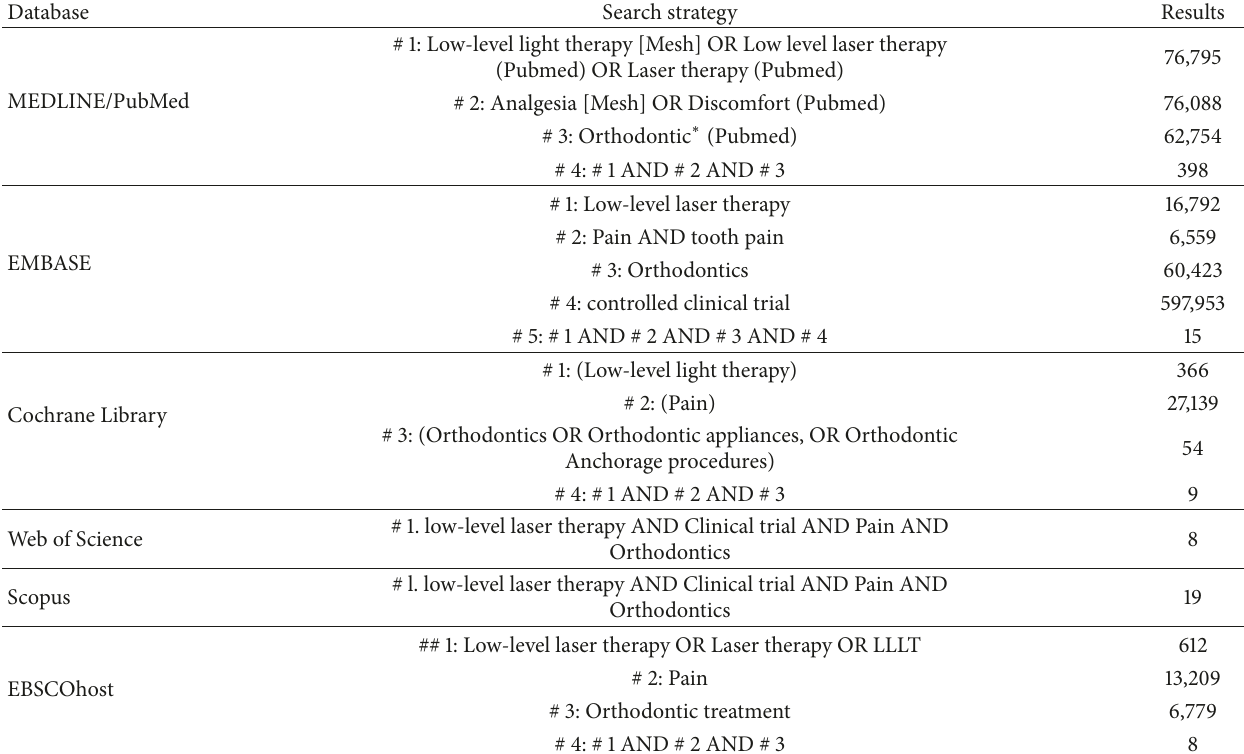
Table 1: Search strategy and results for PubMed, EMBASE, Cochrane Library, Web of Science, Scopus, and EBSCOhost.